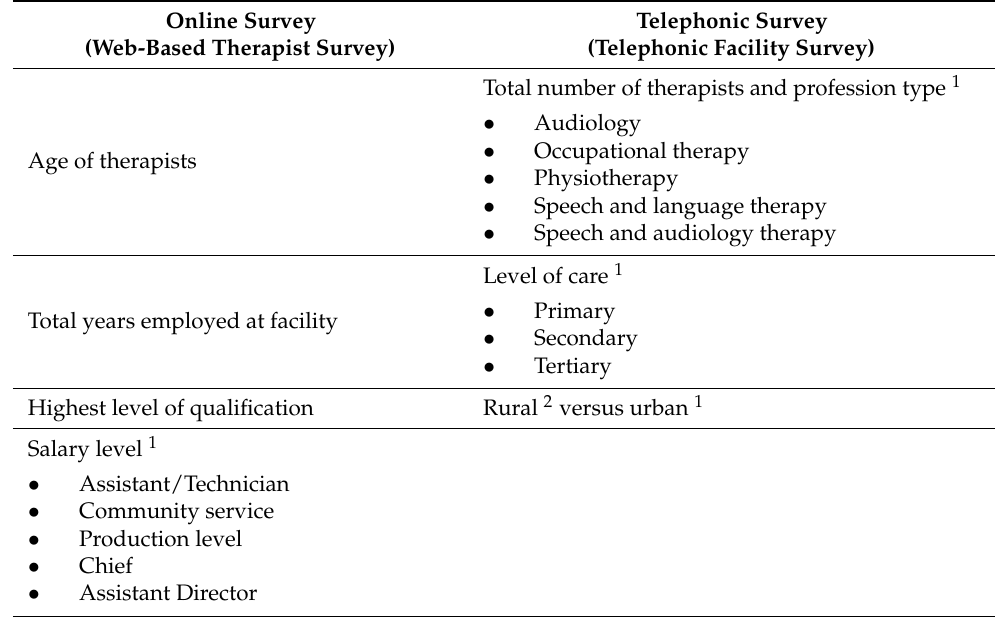
Table 1. Table 1 lists the studied variables; definitions of these are included in Appendix